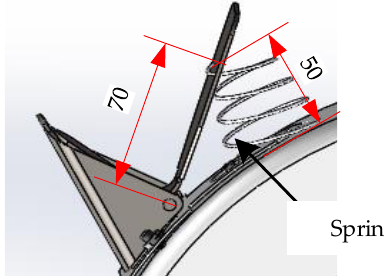
Figure 13. Spring position diagram.